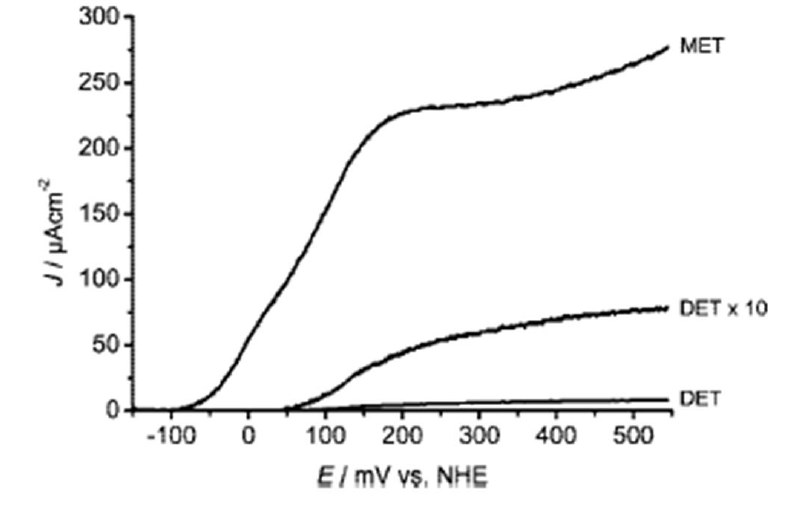
Figure 5. Oxidation of lactose on CDH modified electrodes in the presence (MET) or absence (DET) of Os redox polymer. Reprinted with permission from reference [18]. Copyright 2008 American Chemical